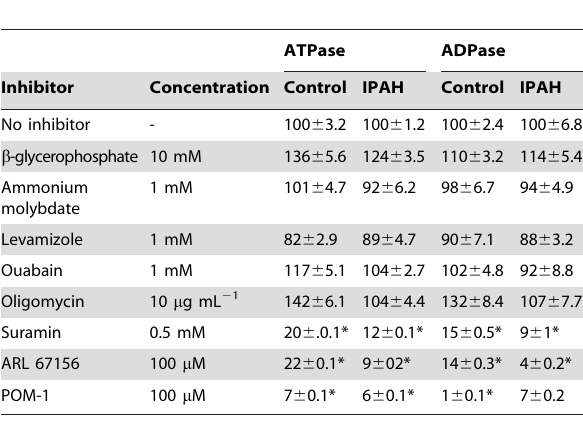
Relative nucleotidase activities expressed as percentage of available substrate dephosphorylated, and is normalized to reactions without inhibitors. The experiment was performed in triplicate using isolated microparticles from three healthy controls and three IPAH patients. *Significant difference from the sample without inhibitor ( P , 0.05).